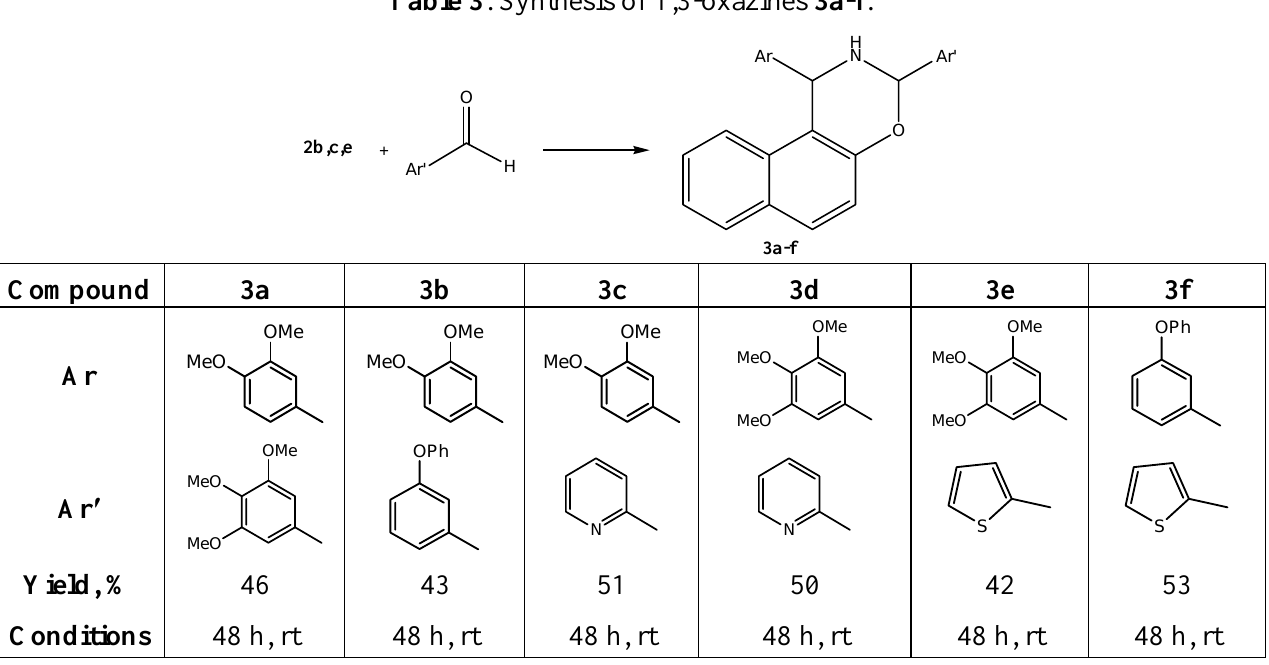
Table 3 . Synthesis of 1,3-oxazines 3a-f